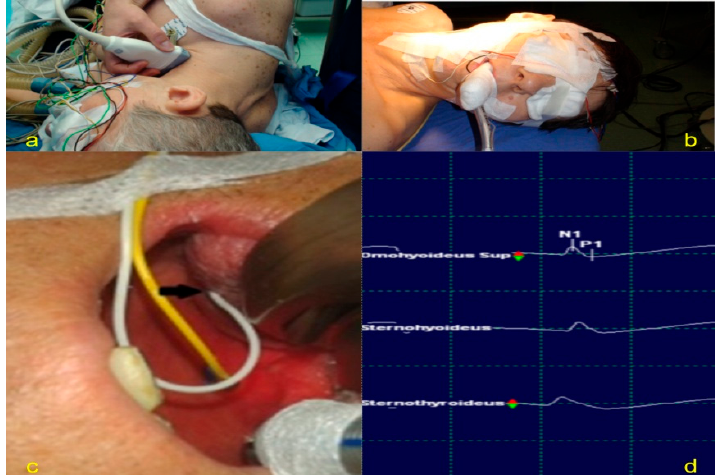
Figure 6. Patient positioning: ( a ) Left lateral decubitus. ( b ) Needle electrode insertion for FN monitoring (o. oris and o. oculi). ( c ) Electrode positioning for hypoglossal nerve monitoring (glossus). ( d ). Recorded potentials during mapping through electrodes positioned in the omohyoideus, sternohyoideus, and sternothyroideus muscles.